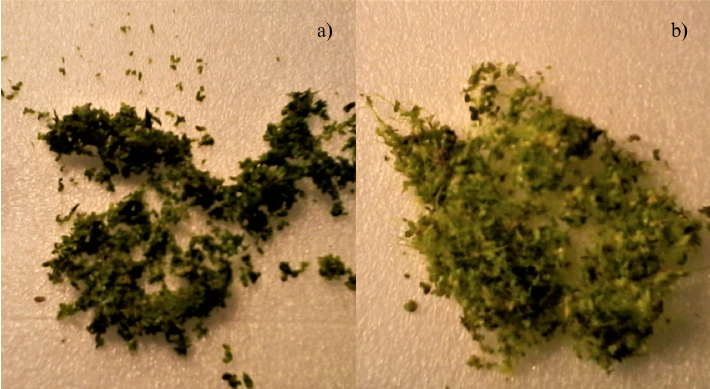
Figure 8. Images of L. minor from ( a ) before the run, fronds of the plant have very short or non-visible roots and are dark green in colour compared to the plant, and ( b ) after the run where fronds are lighter green in colour and roots are longer (vary between 1.5 cm and 4 cm). Individual fronds clumped together by longer